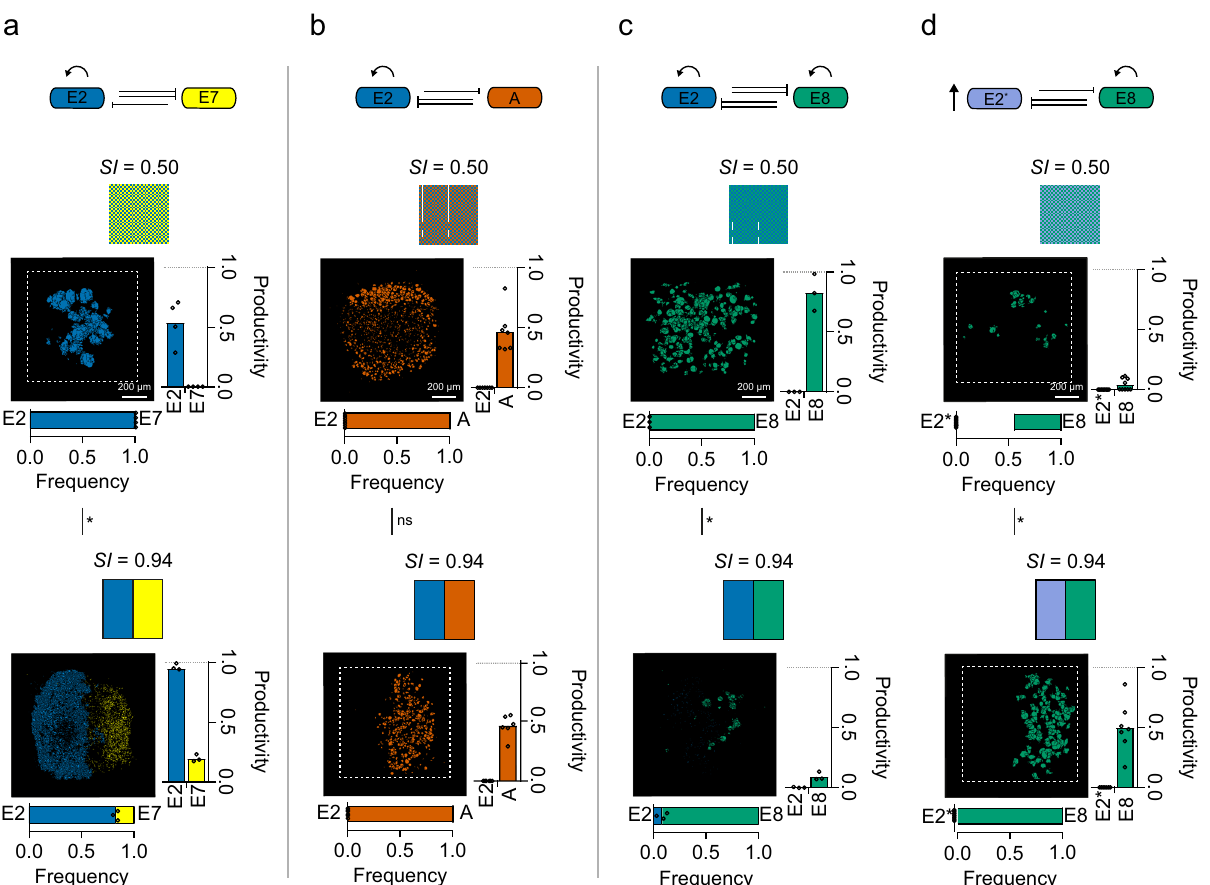
Fig. 3 Micron-scale structure shapes competition between colicin-producing strains and can drive mutual destruction. a – d Competition schematics followed by the corresponding segmented fl uorescence images of E2 cells (blue) and E7 cells (yellow) ( n = 4 and n = 3 for SI = 0.50 and 0.94, respectively) ( a ), E2 cells and A cells (vermillion) ( n = 7 and n = 6 for SI = 0.50 and 0.94, respectively) ( b ), E2 cells and E8 cells (bluish-green) ( n = 3 and n = 3 for SI = 0.50 and 0.94, respectively) ( c ) and E2* cells (bluish-grey) and E8 cells ( n = 9 and n = 7 for SI = 0.50 and 0.94, respectively) ( d ) in genetically mixed ( SI = 0.50) and fully segregated ( SI = 0.94) printed communities after 18 h of competition. In the bacterial warfare schematics, the curly arrows represent autoinduction, the single- inhibition arrows represent lower aggression, the double-inhibition arrows represent higher aggression and the vertical arrow represents a faster growth rate. Above each segmented fl uorescence image is the corresponding printing map. Below each segmented fl uorescence image is a stacked bar chart of the frequencies of strains in each printed array after 18 h of competition. Each data point is a biologically independent replicate, and the mean frequencies of each strain are denoted where the bars meet. The mean frequency of E8 in E2* vs E8 at SI = 0.50 ( d ) is shown as the length of the bar and the data points denote the frequencies of E2*. To the right of each segmented fl uorescence image is a bar chart of the productivities of strains in printed arrays. Each data point is a biologically independent replicate and the mean productivities of each strain are denoted by the heights of the bars. In a – d , unpaired Mann – Whitney tests were performed to assess the statistical signi fi cance in the changes in frequencies of competing strains at different SI values. For a , P = 0.0286; for b , P > 0.9999; for c , P = 0.0286; for d , P = 0.0337 (see Supplementary Tables 4 for statistical tests). In a – d , the term ‘ productivity ’ ( p ) of a genotype a in a printed array after 18 h of competition is de fi ned as p = A a /A S , where A S is the total cross-sectional area that a susceptible genotype occupies after 18 h of competition (at the same starting density and spatial pattern as genotype a ), but without interference